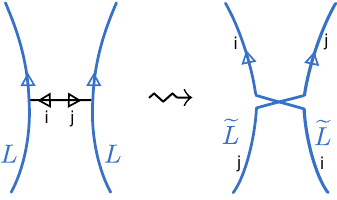
Figure 14 . Left: a web (shown in black) consisting of a single ij -segment with both ends on the link L . Right: a lift e L containing the lift of the web.